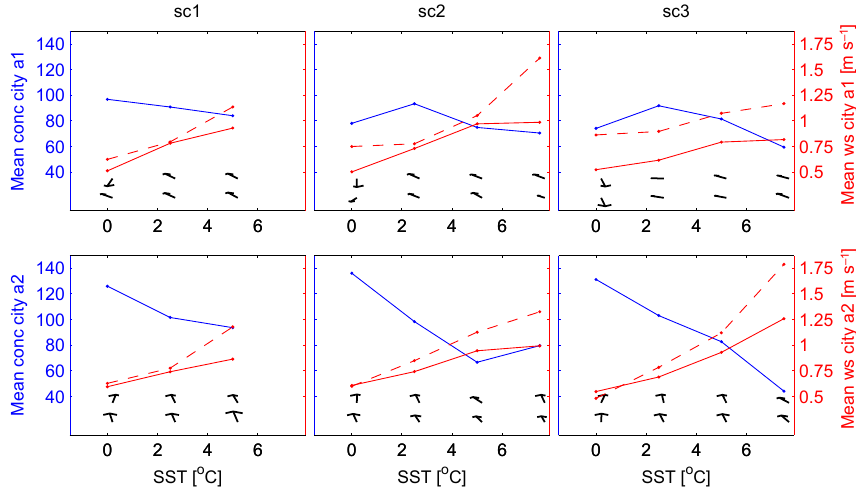
Figure 8. Mean passive tracer concentration (blue) and wind speed at 55m (red, dashed) and 10m above the surface (red, solid) for area 1 (a1) and 2 (a2), as indicated in Fig. 1 for the three wind-speed scenarios as indicated in Table 1. The wind vectors indicate the mean wind direction in the area at the 55m height level (top panels) and 10m above the ground (bottom panels). Vectors point into the direction of the flow. All data are averaged over the last four output steps of the 12h simulations, corresponding to Fig.